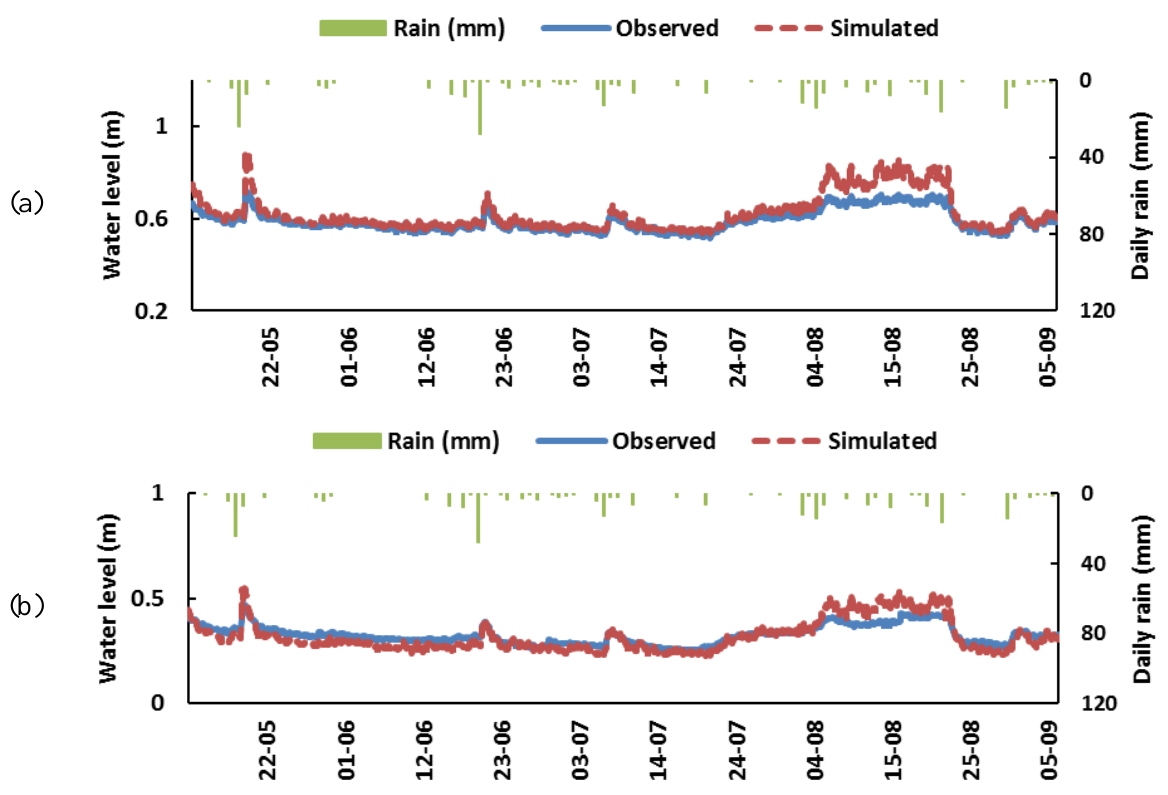
Figure 8. Time series (hourly) of observed and simulated water levels (a) upstream and (b) downstream of Basin B1.